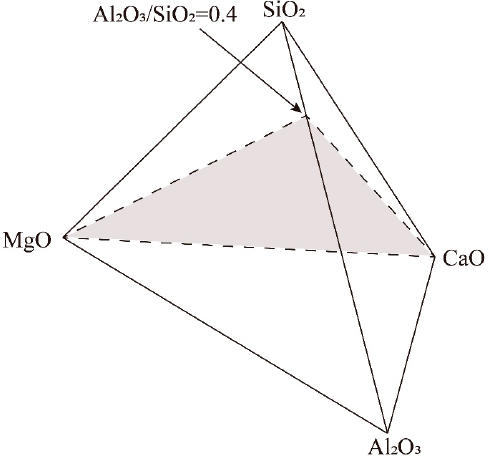
Figure 1. Presentation of the pseudo-ternary phase diagram in the CaO-MgO-(SiO 2 +Al 2 O 3 ) system at fixed Al 2 O 3 /SiO 2 weight ratio of 0.4.